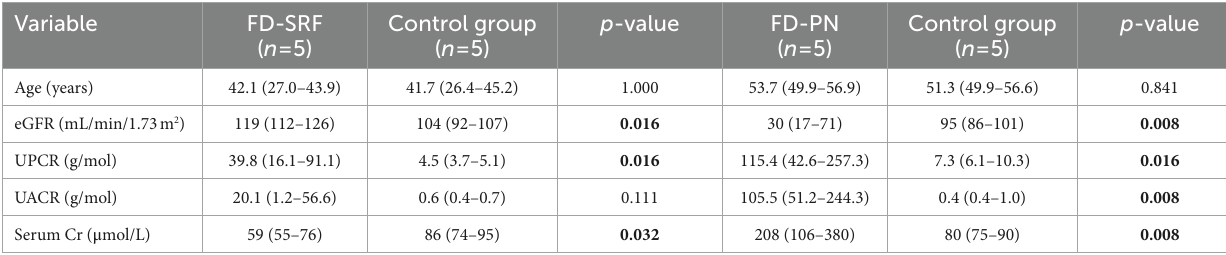
TABLE 1 Discovery cohort